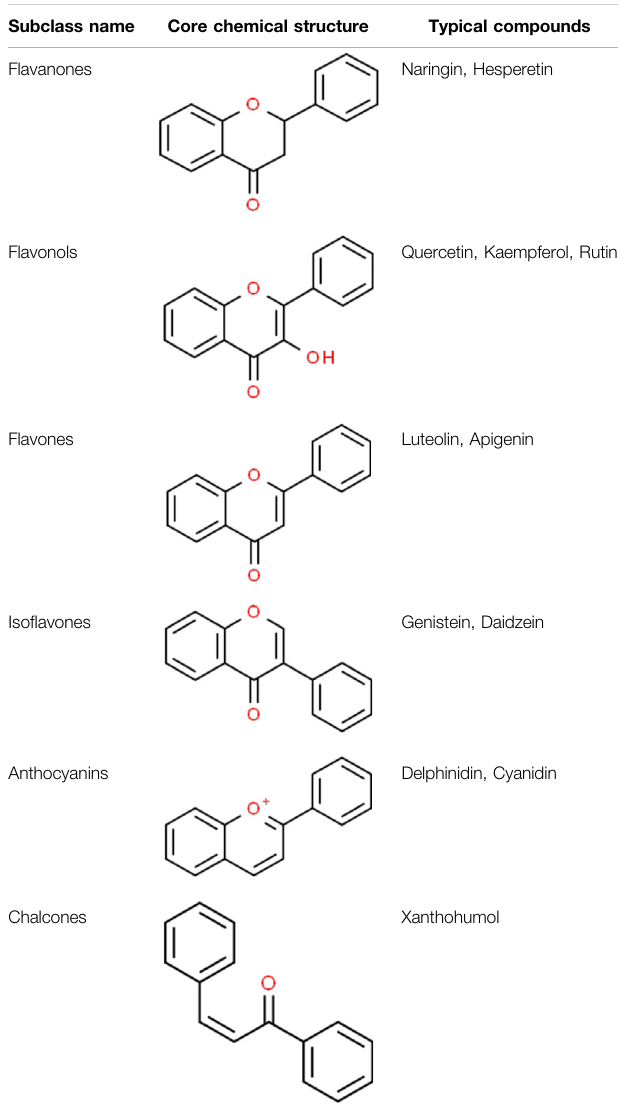
TABLE 1 | Structure of fl avonoids subclasses.